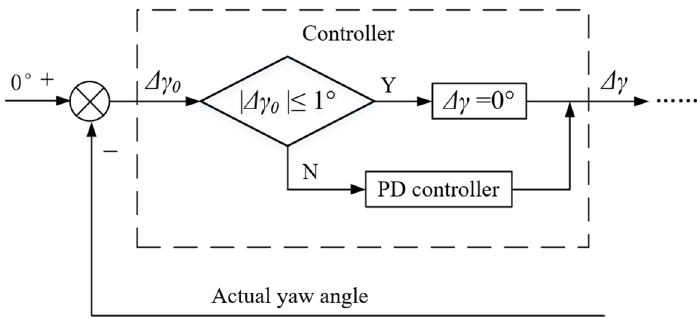
Figure 11. Controller design of hexapod robot yaw angle correction algorithm.